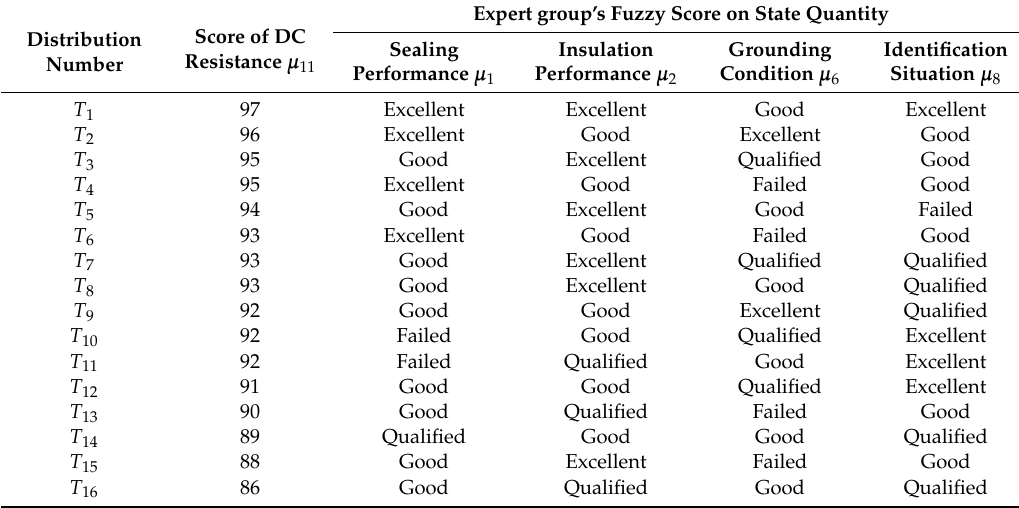
Table 6. The original data of distribution transformer.